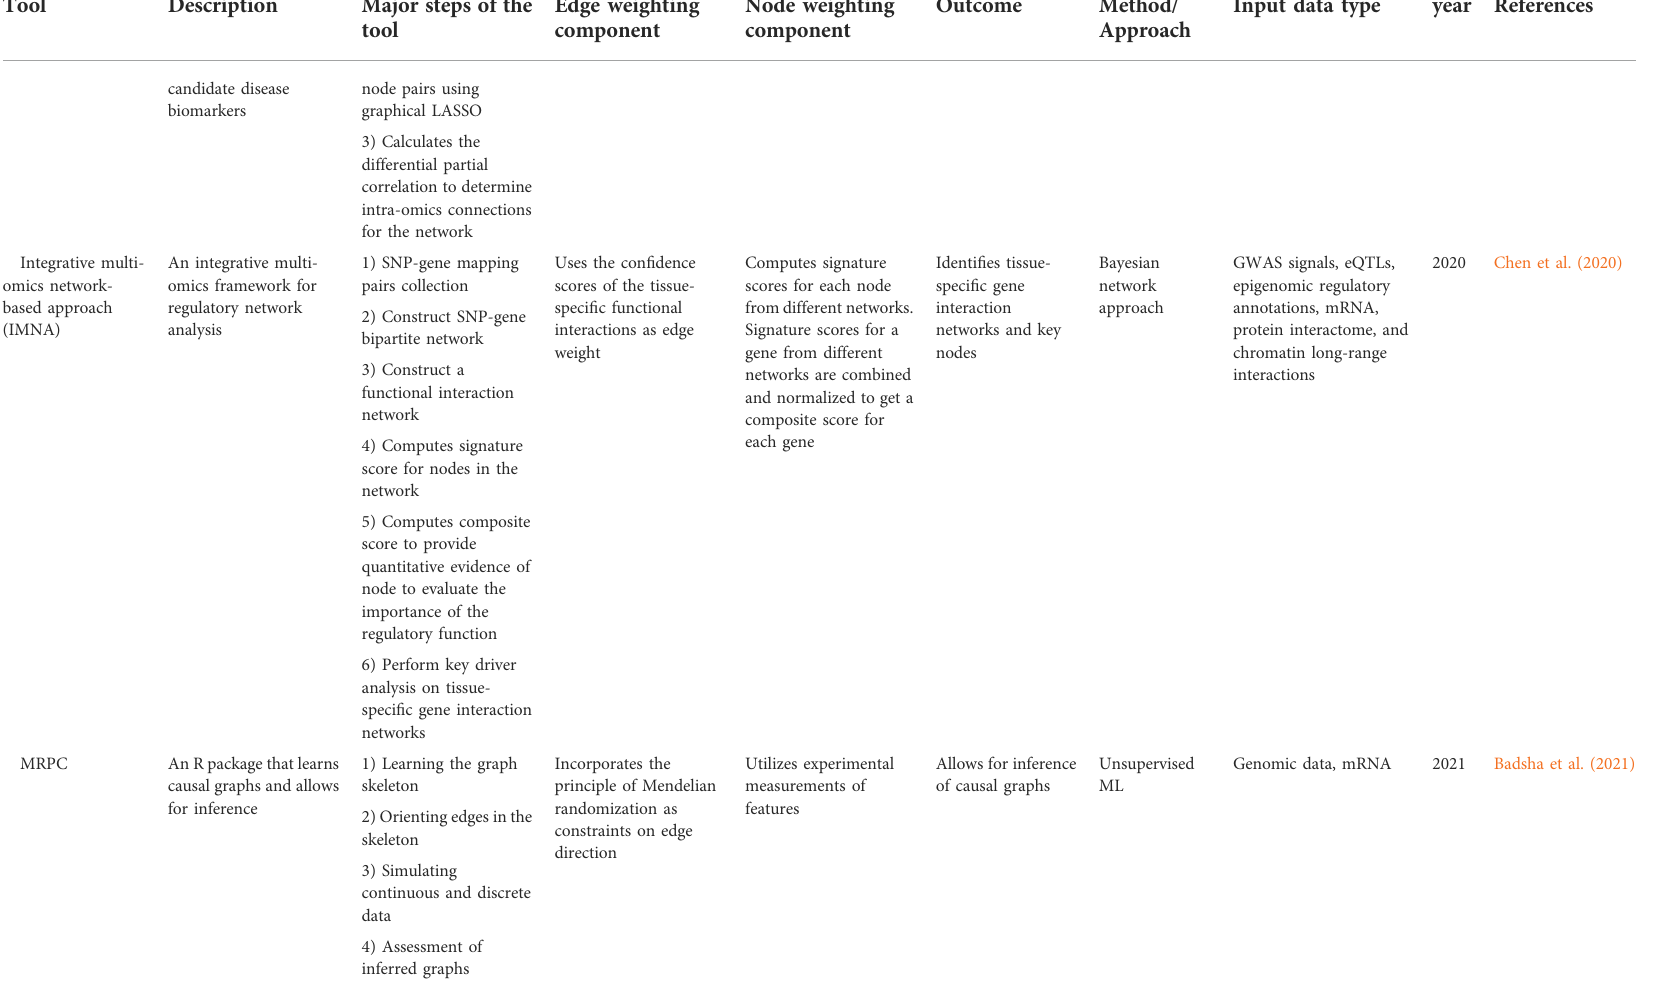
TABLE 1 ( Continued ) Network-based multi-omics integrative tools for predicting biomarkers, crosstalk, disease subtypes, and subnetworks/enriched